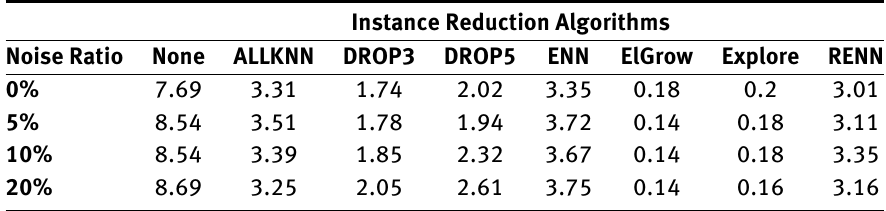
Table 13: Average Number of Attributes for unpruned trees at different noise ratios Instance Reduction